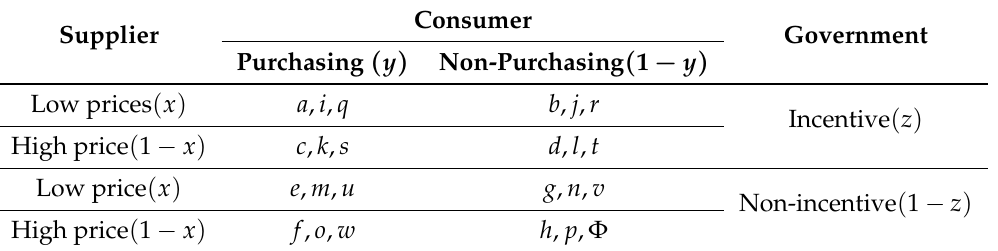
Table 1. Tripartite game